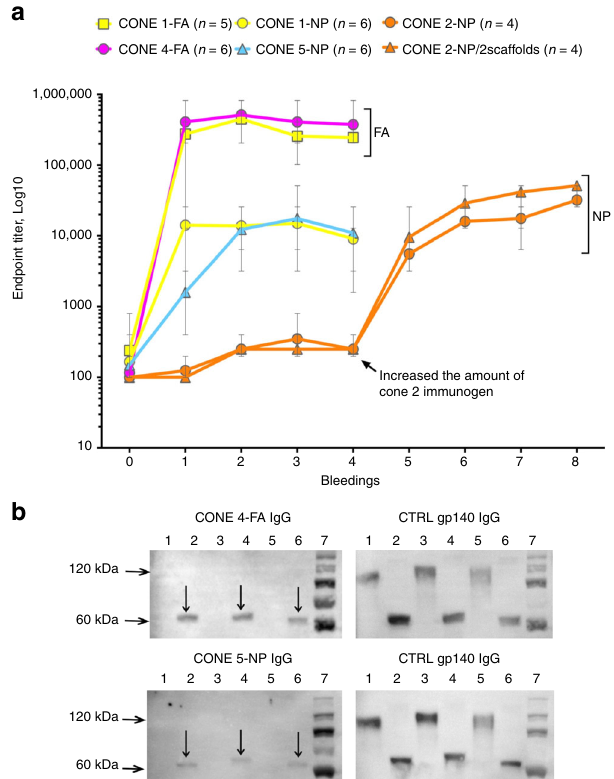
Fig. 3 Characterization of antibodies in the sera from rabbits immunized with CONEs. a Anti-CONE endpoint titers were determined by ELISA during the immunization process. The data represent the mean titers for each group of rabbits. The boost injections were performed monthly, with bleedings performed three weeks after each boost. n = number of rabbits (4 – 6, indicated for each immunogen). Error bars represent standard deviation. b Western blots demonstrating the binding of puri fi ed rabbit IgG to PNGase-deglycosylated gp120 (~60 kDa band, lanes 2, 4, and 6 in plots of CONE 4 and 5). No interaction between the IgG and glycosylated gp120 (~120 kDa band, lanes 1, 3, and 5 in plots of CONE 4 and 5) was observed. (Left) blots treated with IgG puri fi ed from rabbits immunized with CONEs; (Right) same blots stripped from CONE IgG and treated with anti-gp140 IgG as a positive control. Lanes: 1 – 2, 1086 gp120 D7 293F; lanes 3 – 4,